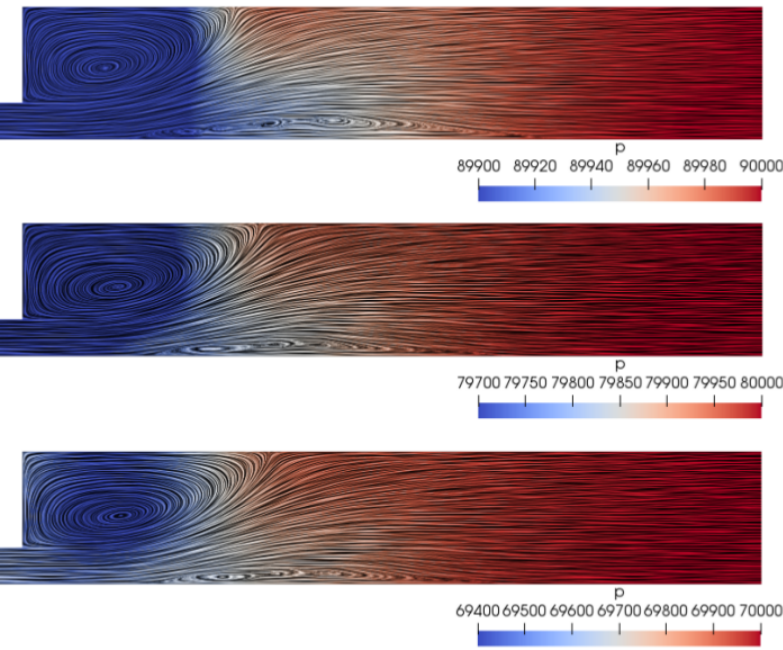
Figure 14. Velocity streamlines and pressure contours in the gripper terminal region at different outlet pressures ( d = 0.77 mm, L = 32.2 mm, D = 3.6 mm).